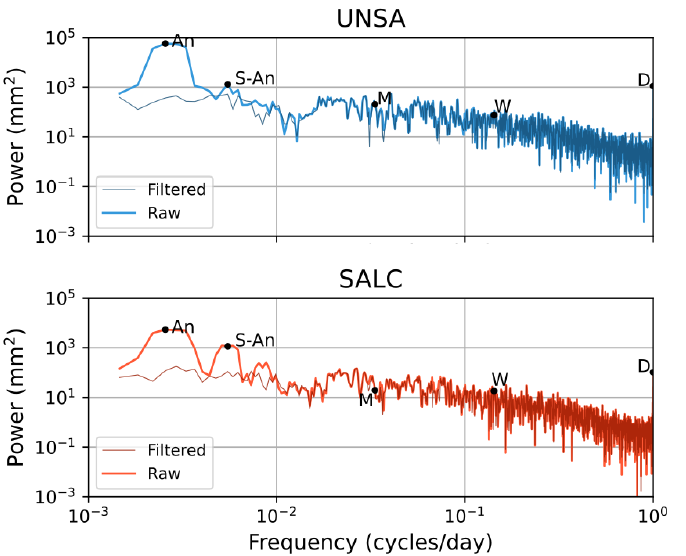
Figure 7. Power spectral densities (PSDs) of the low-elevation UNSA (upper panel) and the high- elevation SALC stations (lower panel). The thick and light-coloured lines represent the raw PSDs, while the thinner lines show the filtered